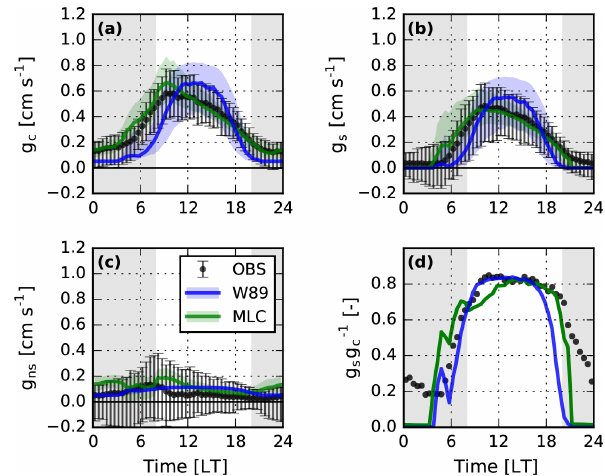
Figure 6. As in Fig. 5 but for Hyytiälä.